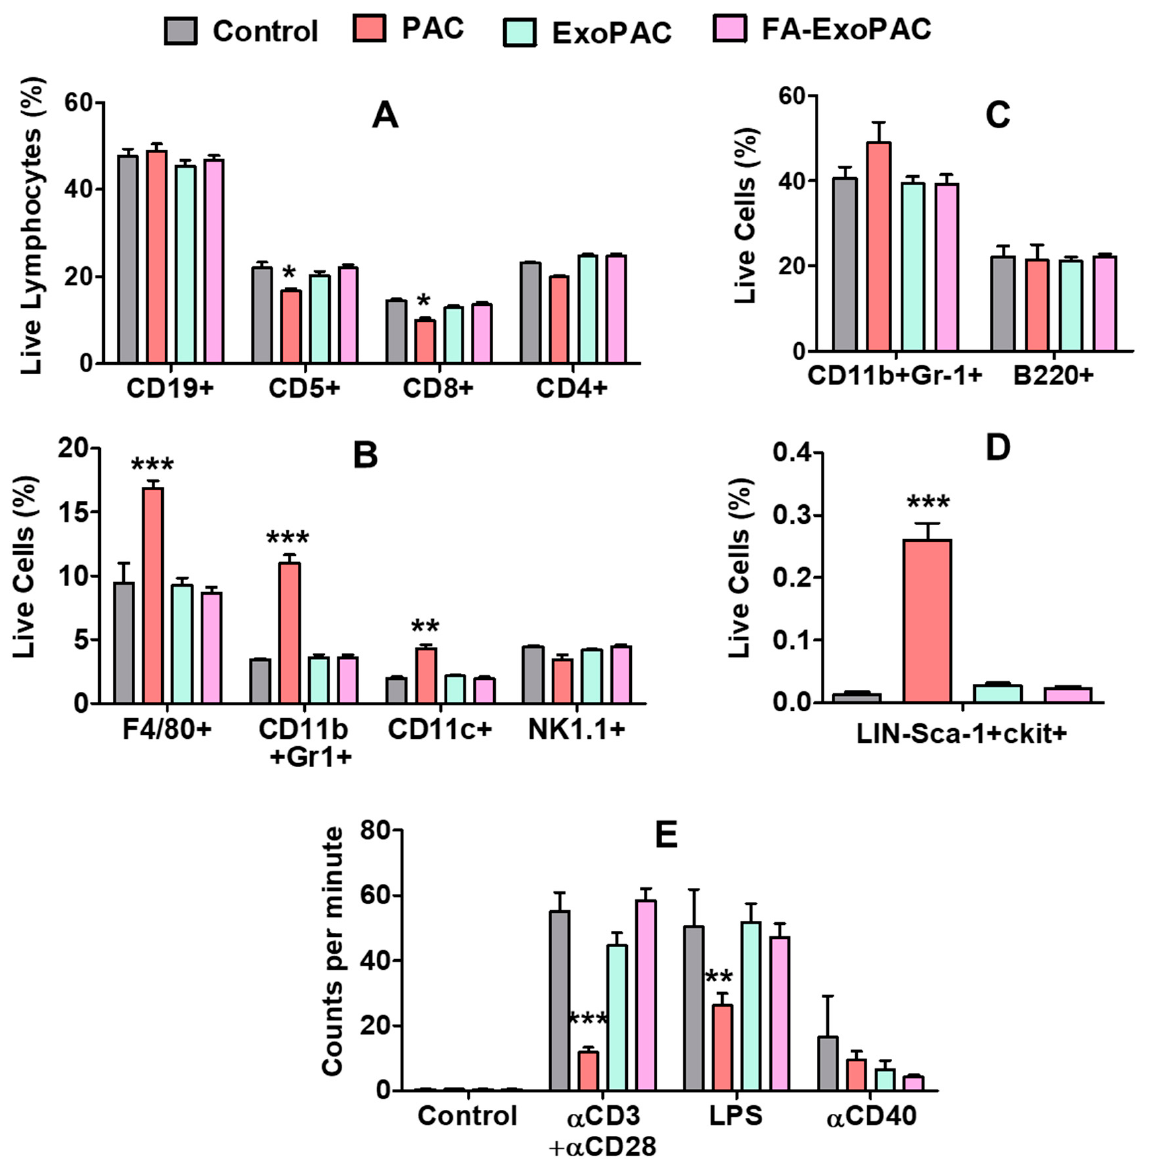
Figure 7. Potential immunotoxicity of PAC and FA-ExoPAC. Female C57BL/6 mice were treated with Exo, PAC and FA-ExoPAC for four weeks. At euthanasia, spleen and bone marrow cells were collected. Splenic cells were stained with multiple fluorochrome-conjugated antibodies. Samples were run using LSRII cytometer and data was analyzed by FlowJo software. Effect of treatment was analyzed on B cells, total T-cells, T helper cells, and cytotoxic T-cells ( A ), macrophages, neutrophils and dendritic cells ( B ), B cell ( C ), %LSK cells ( D ) and T-cell proliferation ( E ). All statistical analysis was performed by two-way ANOVA and compared with untreated control. *, p < 0.05; **, p < 0.01; ***, p < 0.001.